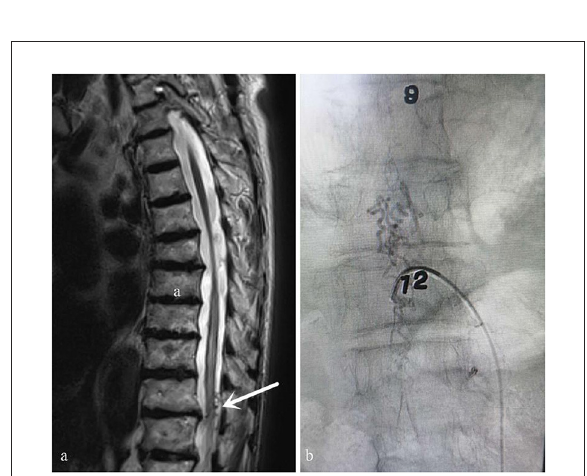
FIGURE2 Case 2. A 73-year-old man who did not have typical signs of spinal cord edema and vessel flow voids on the cord on MRI (a) (white arrow: Atypical angiogram). This patient was misdiagnosed with thoracic spinal stenosis by an orthopedic surgeon. His symptoms were not completely consistent with the symptoms of thoracic spinal stenosis and worsened after he was treated for thoracic spinal stenosis. After MDT consultation, the diagnosis of spinal DAVF was confirmed via DSA performed by a neurosurgeon. The fistula was located at T9-10 (b)